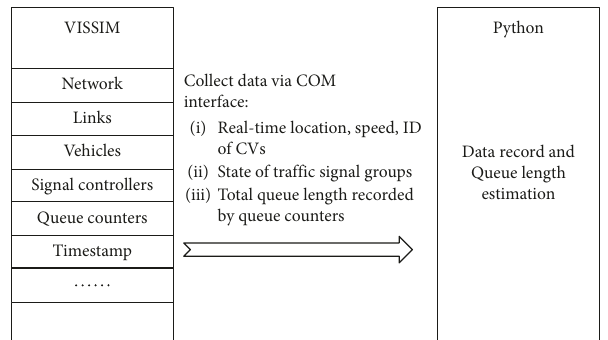
Figure 4: Collecting CV data via COM interface. Table 2: Samples of recorded simulation